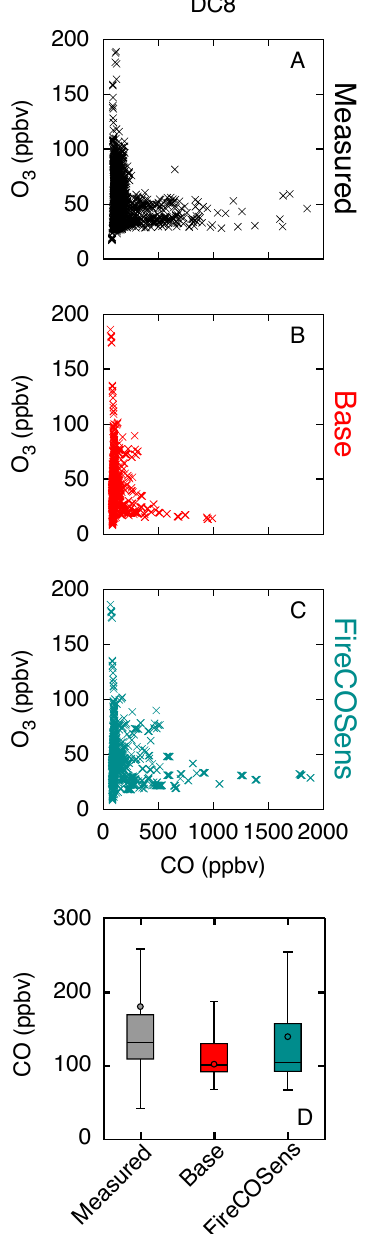
Fig. 4. Ozone versus CO correlations for the DC8 data ( a ), model base run ( b ) and a model run with CO emissions from fires x2, FireCOSens ( c ) for 29 June, 1, 4 and 5 July 2008. For comparison, model results are extracted along the DC8 flight tracks. Box and whisker plots for CO (measurements, model base run, and FireCOSens run) are shown in panel ( d ). For these plots, the box indicates the 25% and 75% percentiles, the line represents the median, and the circle shows the mean. In the measured data, very high values of CO measured in fires results in a mean value above the 75% percentile.